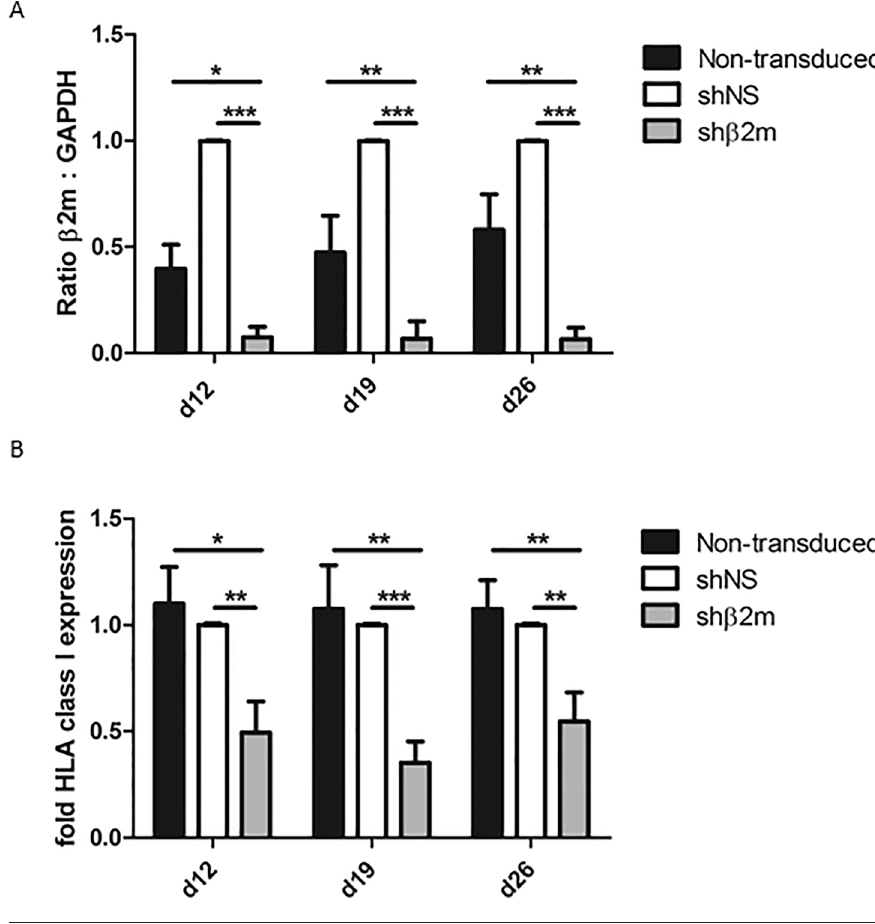
Figure 4. Megakaryocytes (MKs) differentiated from HLA-universal iPSCs remain silenced for HLA class I. (A) Relative levels of β 2m transcripts in shNS- or sh β 2m- expressing and nontransduced MKs assessed by real time PCR. (B) Surface expression of HLA class I mol- ecules in nontransduced, nonsilenced and silenced MKs analyzed by flow cytometry. Cells were harvested and stained with HLA-specific antibody w6/32. Both graphs depict means and SD of three independent experiments. *** p ≤ 0.001, ** p ≤ 0.01, * p ≤